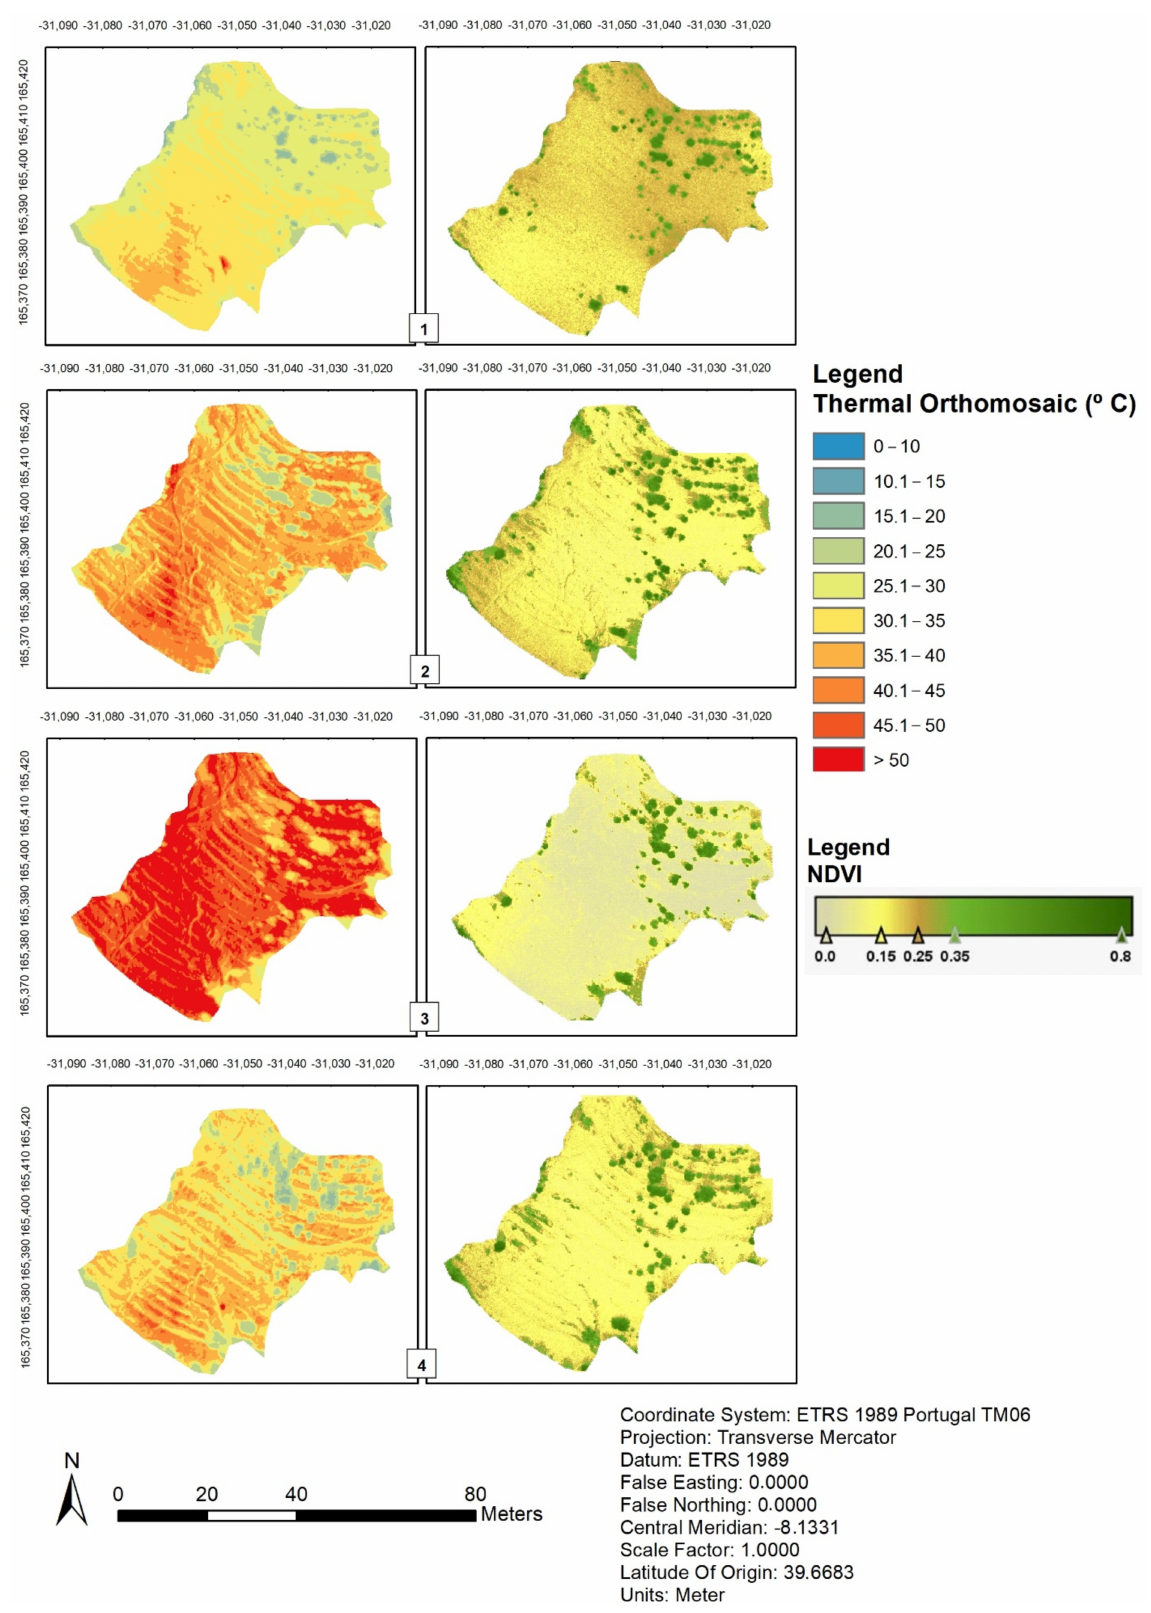
Figure 8. Comparison of temperature ( ◦ C) and NDVI, respectively (1—July 2019; 2—May 2020; 3—August 2020; 4—November